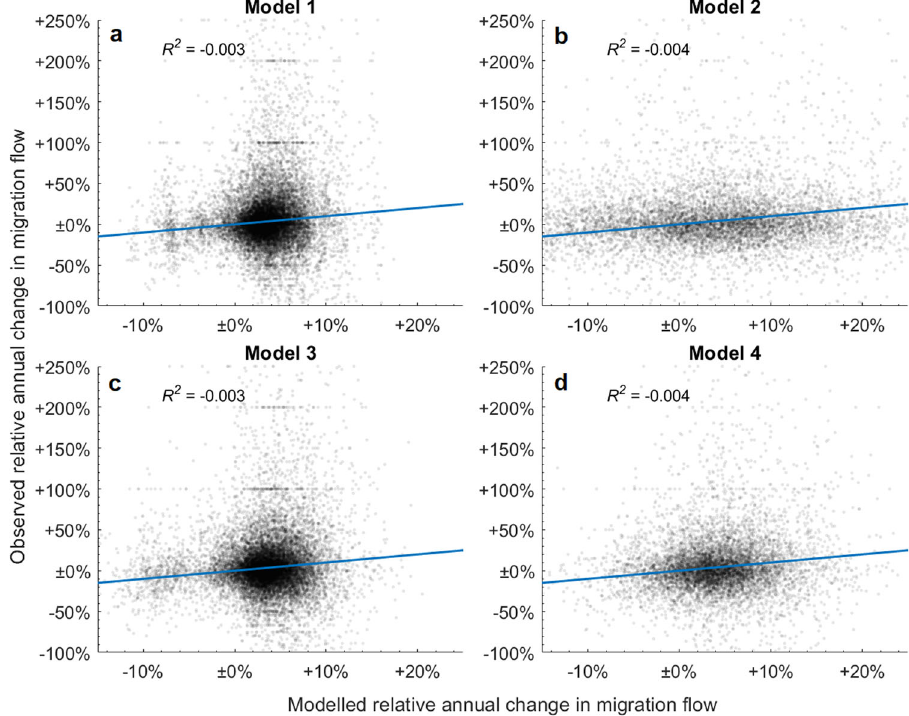
Fig. 2 Modelled and observed temporal changes in migration fl ows. Each marker represents the observed and modelled (based on Models 1 – 4; a – d ) relative annual change in the number of migrants from a country of origin i to a country of destination j between a year t and the following year t + 1 (Eq. (6)). R 2 values correspond to Eq. (7). For visual clarity, axes were capped. Blue lines represent 1:1 relationships. HUMANITIES AND SOCIAL SCIENCES COMMUNICATIONS| (2022) 9:56